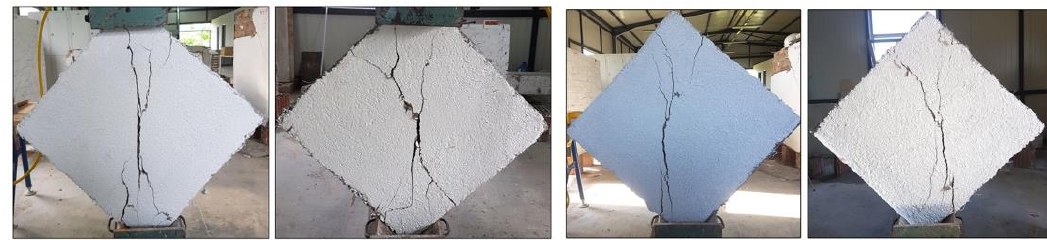
Figure 18. Failure mode of SW-3-PF.